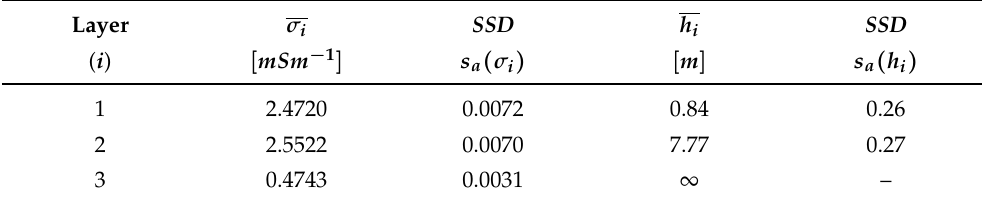
Table 10. Mean values and sample standard deviations of 3D mapping of